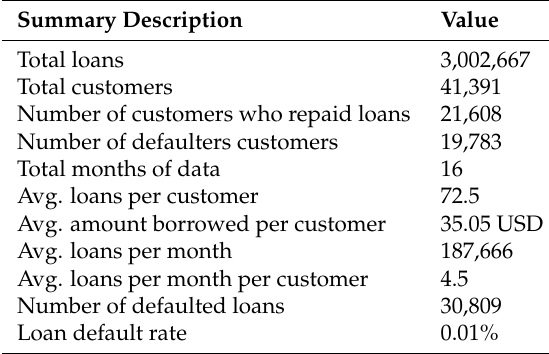
Table 3. Summary of the ComzAfrica